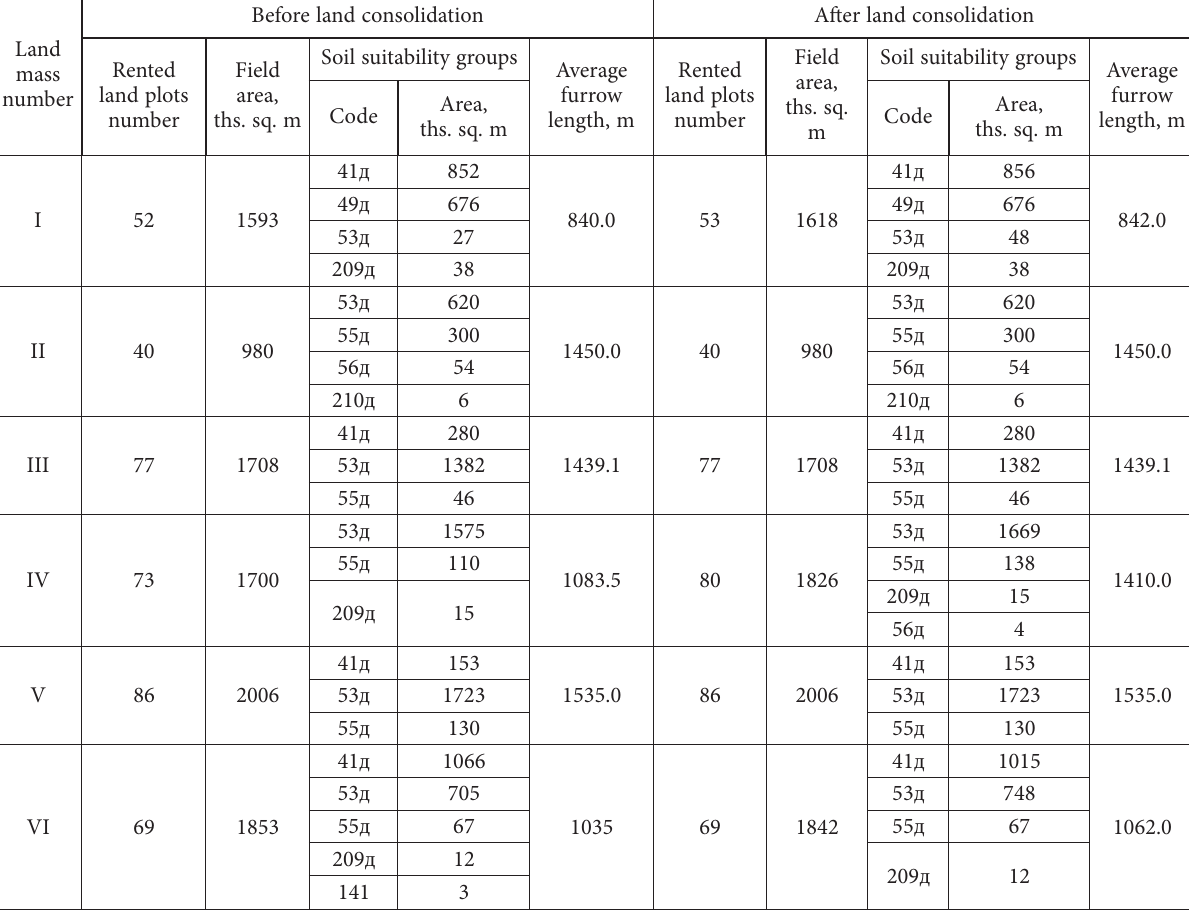
Table 5. Agricultural enterprise land tenure characteristics (option